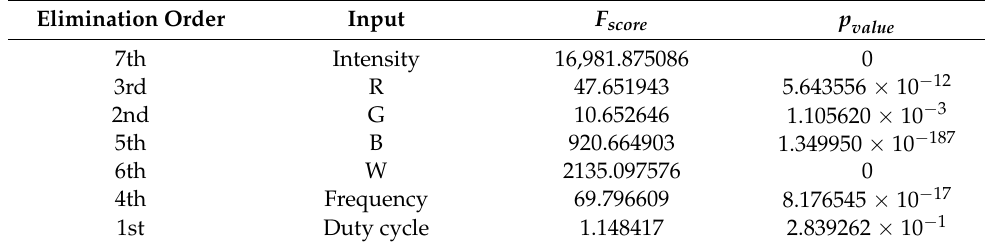
F Figure 7. score Table 6. F score and p value feature selection with